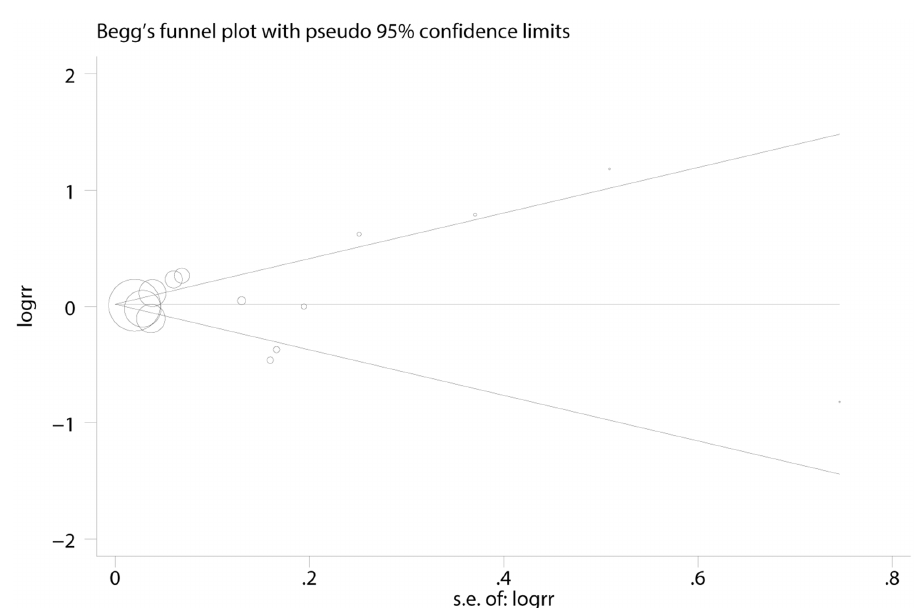
Fig 5. Funnel plots of exposure to fluoride in the drinking water and hip fracture risk for assessment of publication